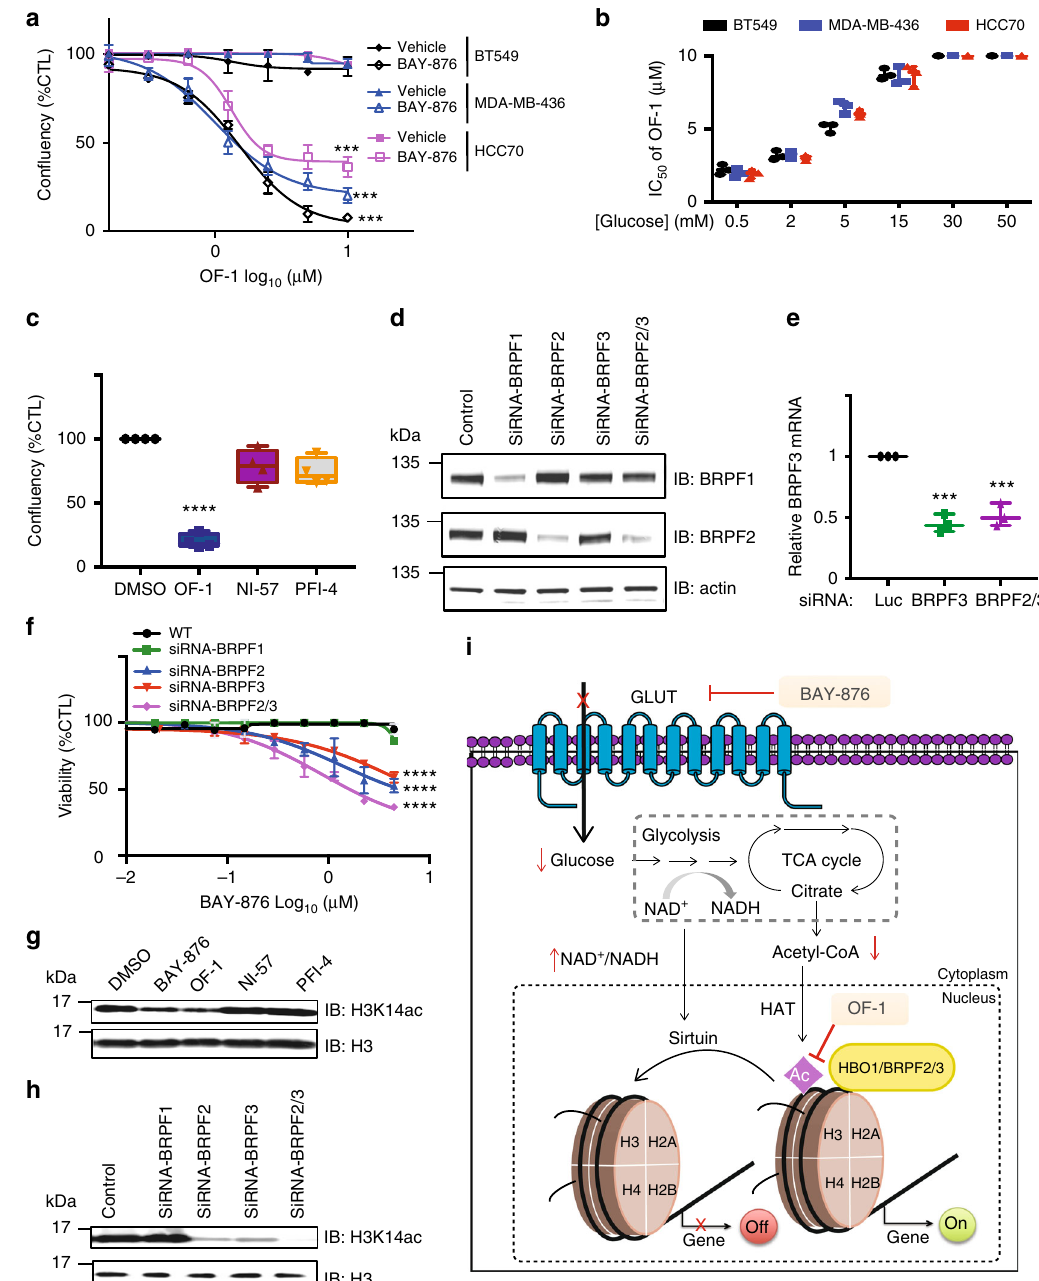
Fig. 7 BRD inhibitors reveal a metabolic/epigenetic circuit involving HBO1 in TNBC. a Dose-dependent curves for cells lines treated with indicated concentrations of OF-1 with or without 3 μ M BAY-876 for 7 days. Graph indicates mean, error bars denote s.d. from eight wells (from two independent assays) and p -value was computed using the Benjamini-Hochberg t test; *** p < 0.001. b Average IC 50 values of OF-1 in cells cultured under a range of glucose concentrations for the indicated three TNBC cell lines. Cells were treated with increasing doses of OF-1 for 7 days and the number of viable cells was determined by Incucyte ZOOM live cell imaging device. Error bars denote the s.d. values of independent experiments. c Con fl uency of MDA-MB- 436 cells treated with indicated 3 μ M BRPF inhibitors: OF-1, NI-57, and PFI-4 for 7 days. Graph indicates mean, error bars denote s.d. from eight wells (from two independent assays) and p- value was computed using the Benjamini-Hochberg t test; *** p < 0.001. d Immunoblot validation of BRPF knockdown in MDA-MB-436 cells. e Quantitative real-time PCR (RT-qPCR) validation of BRPF knockdown in MDA-MB-436 cells. P -value computed using Benjamini-Hochberg t test; *** p < 0.001. f Dose-dependent response of BAY-876 in BRPF-knockdown cell lines. g Immunoblot analysis of H3K14 acetylation in MDA-MB-436 cells following BAY-876 and BRPF inhibitor treatment for 5 days. h Immunoblot analysis of H3K14 acetylation in MDA-MB- 436-knockdown lines. i Schematic illustration of a metabolic/epigenetic circuit involving GLUT1 and HBO1. Raw data images are available in Supplementary Fig. 4